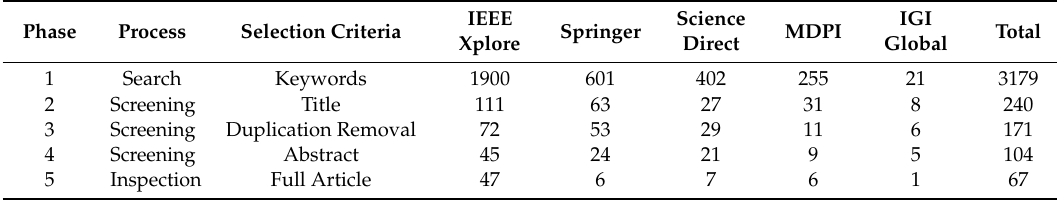
Table 4. Primary selection process for retrieved